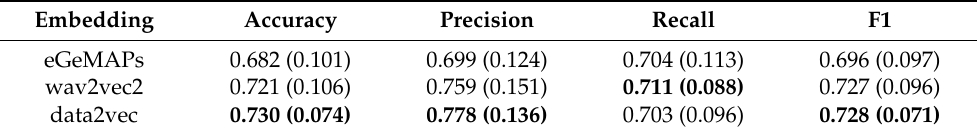
Table 3. Classification results for the AD detection task using data2vec embeddings, wav2vec2 embeddings, and eGeMAPs acoustic feature set based on the 10-fold CV with the end-to-end AD clas- sifier. The standard deviation for each metric is reported. Bold indicates the best overall performance for that metric. F1 score is the harmonic mean of the precision and recall.